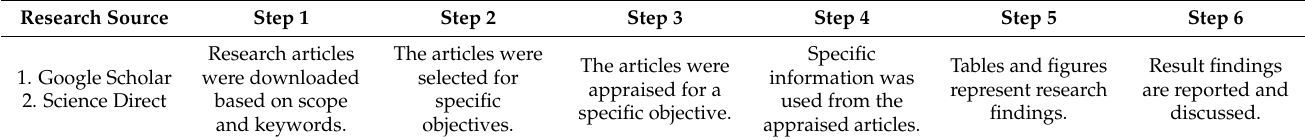
Table 1. A systematic step by step process to acquire research articles for each